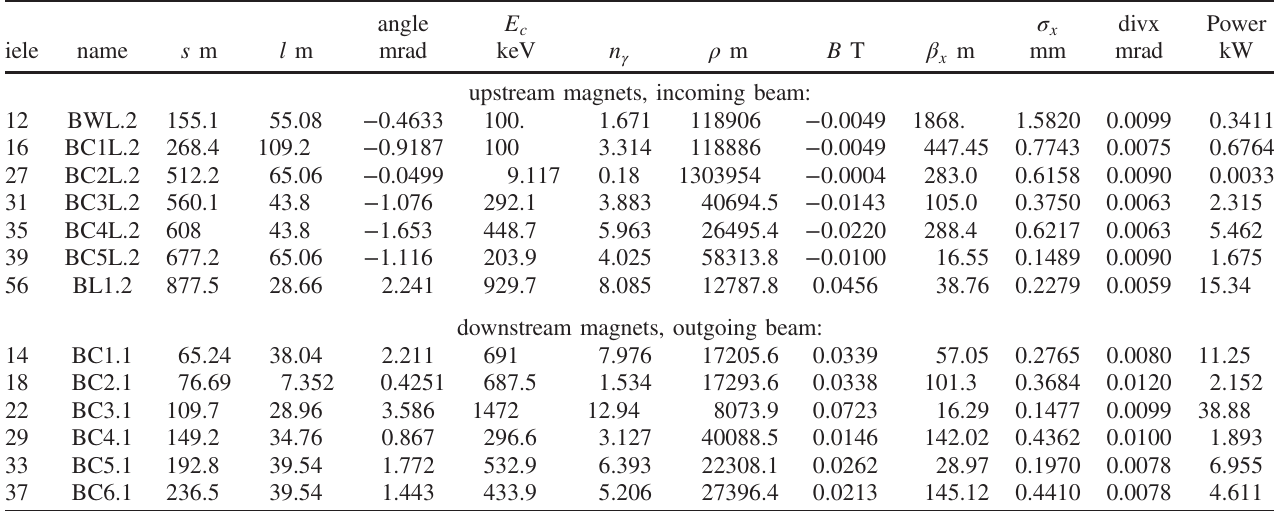
TABLE III. MDIS IM output of the SR from the bending magnets upstream and downstream the IP. The first two columns show the element number and magnet name; followed by the end position of the magnet s and magnet length l , the bending angles, critical energy, average number of photons radiated by the passage of a single electron, bending radius ρ , magnetic field, horizontal β function, rms beam size and beam divergence, and the power radiated by SR in this magnet by a single beam, using the beam parameters of Table I.